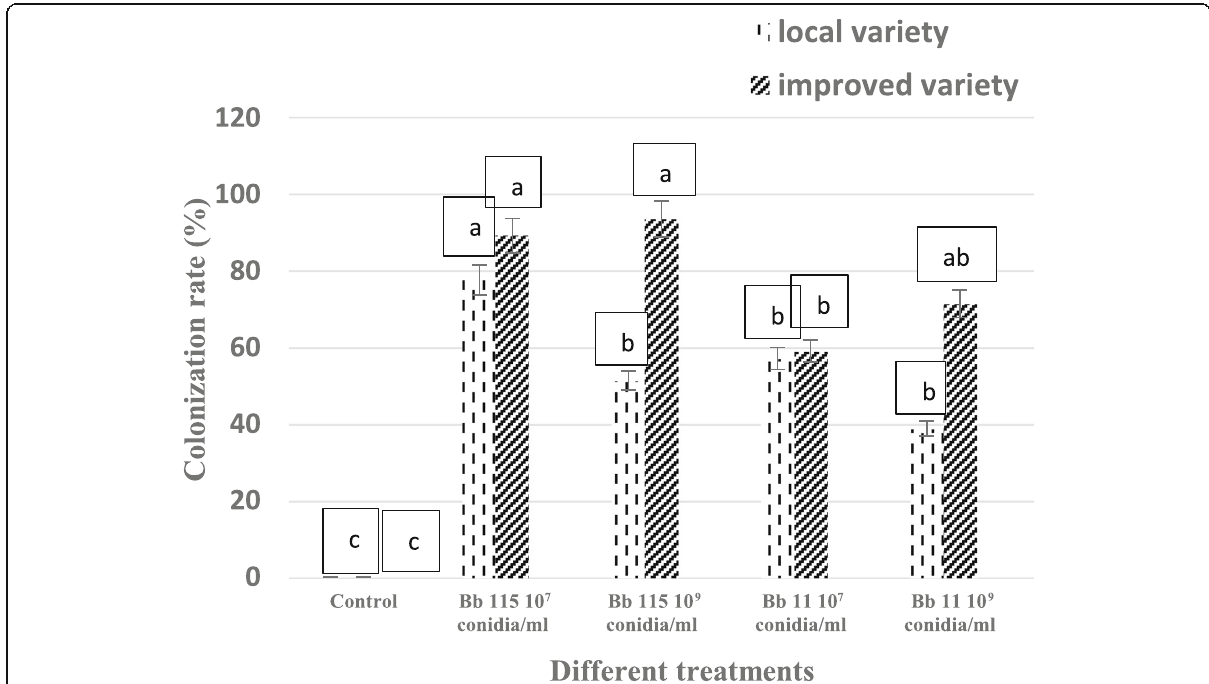
Fig. 4 Root colonization rate (%) by Beauveria bassiana in two tomato varieties with seed coating inoculation. Histograms with the same letters are not significantly different at the 5% level (SNK). With Bb115 10 7 conidia/ml = Beauveria bassiana Bb115 at 10 7 conidia/ml; Bb115 10 9 conidia/ ml = Beauveria bassiana Bb115 at 10 9 conidia/ml; Bb11 10 7 conidia/ml = Beauveria bassiana Bb11 at 10 7 conidia/ml; Bb11 10 9 conidia/ml =